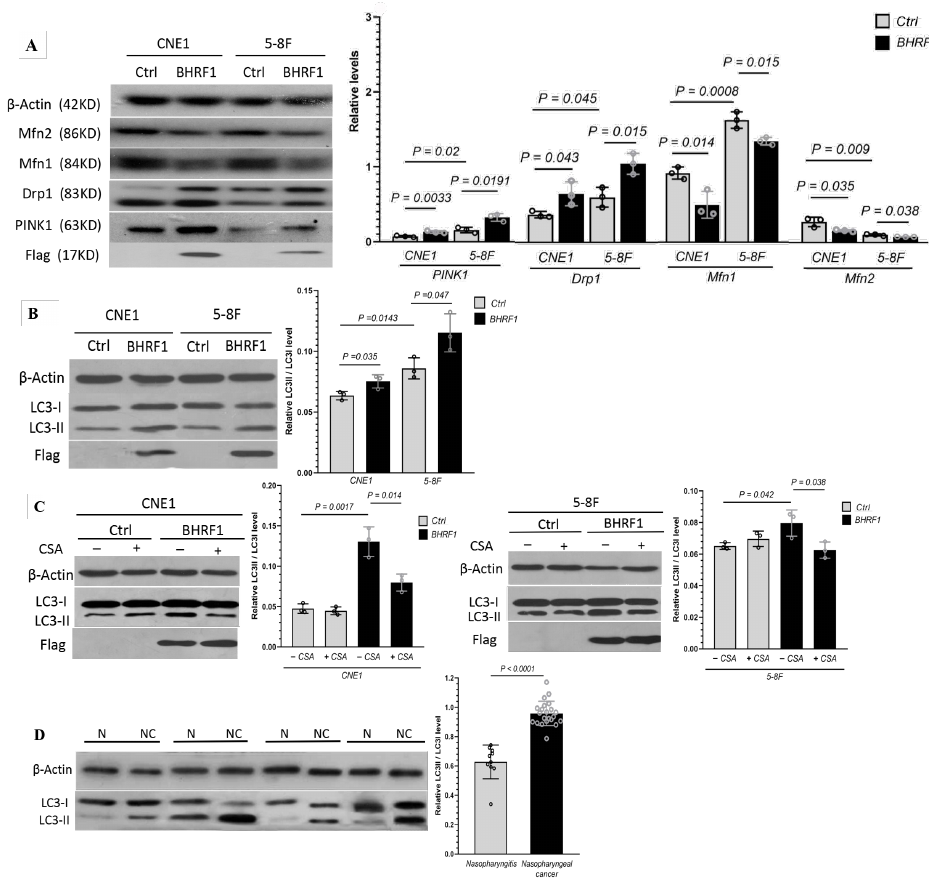
Figure 7. Mitophagy mediates the e ff ect of MMPT on cell survival in NPC cells and tissues. ( A ), Relative protein expression of Mfn2, Mfn1, Drp1, PINK1 in control cells and BHRF1 high expression cells. ( B ), The LC3II / LC3I protein level in NPC cell lines by western blotting; ( C ), The LC3II / LC3I protein level with or without CsA by western blotting in NPC cell lines; ( D ), The expressions of LC3II / LC3I protein level in nasopharyngeal cancer and nasopharyngitis tissues by